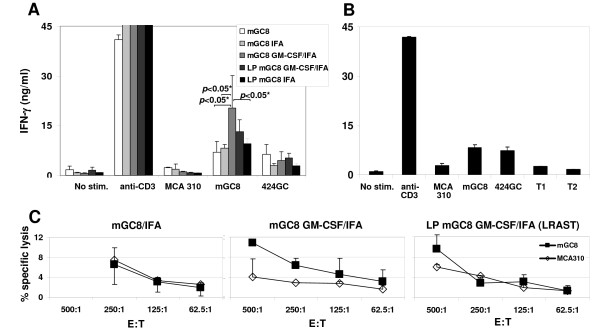
Tumor-specific IFN-γ release and cell-mediated cytotoxicity after vaccination with mGC8 cells and GM-CSF. T cells generated from TVDLN at day nine after vaccination were polyclonally activated and expanded as described in the Methods section and tested for tumor-specific IFN-γ release and cell-mediated cytotoxicity. In the cytokine release assay, T cells were either cultured alone, with an anti-CD3 antibody, with a syngeneic but unrelated tumor, MCA 310, with the related tumor cells 424GC or with mGC8 cells. Supernatants were harvested 18 h later for quantification of IFN-γ (and IL-5, not shown) by ELISA. (A) Vaccination with mGC8 with or without LP, GM-CSF, and IFA. Data are presented as the mean of two independent experiments in which co-cultures were performed in duplicate (± SE). IFN-γ secretion was significantly increased in the mGC8 GM-CSF/IFA group (p < 0.05) compared with the mGC8-, mGC8 IFA-, and LP mGC8 IFA-groups. LP, induction of lymphopenia followed by reconstitution. (B) Vaccination with mGC8 cells; TVDLN were additionally co-cultured with the TAg peptides T1 and T2. Means of duplicate measurements and SE are indicated (n = 4 for tumor cell lines and the non-stimulated control). (C) Cytotoxicity of TVDLN against mGC8 (black symbols) and MCA310 (open symbols) at declining effector-to-target cell ratio (E:T). Means of duplicate measurements (+/- AVEDEV) are shown. The experiment was repeated after restimulation of the LN cells with irradiated mGC8 tumor cells (10:1) followed by 5 days culture in CM supplemented with 60 IU/ml IL-2 revealing similar results (not shown). AVEDEV: average of the absolute deviations of the numbers above from their mean.